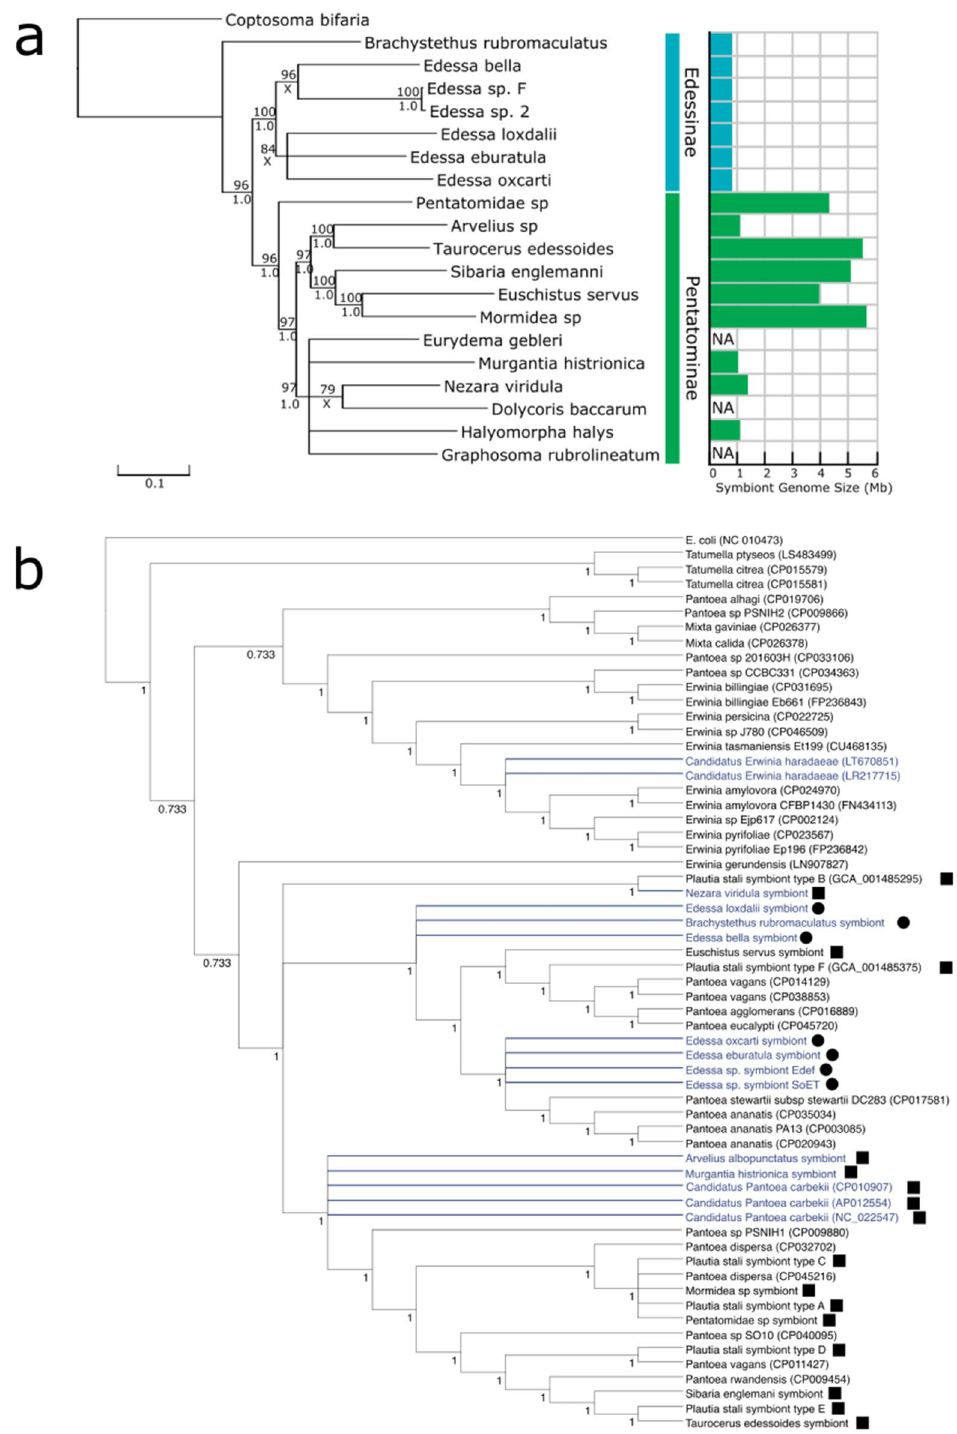
Figure 2. Host and symbiont relationships: ( a ) Stink bug mitochondrial tree with their respective symbiotic bacterial genome size. Nodes with lower than 60% bootstrap support were collapsed. Numbers above nodes represent bootstrap support while numbers underneath represent posterior probability from Bayesian Inference run. X indicates lower than 0.8 posterior probability. NA-genome size was not available. ( b ) Consensus cladogram of representative genomes of Erwiniaceae and stink bug symbionts. Individual FastTree reconstructions for the 10 longest protein sequences identified to be common for all taxa using reciprocal best hit Blast. E. coli was used as an outgroup. NCBI accession numbers for genomes are shown in parenthesis. Squares indicate a symbiont of a member of the Pentatominae while circles indicate symbionts of Edessinae. Numbers at nodes indicate Shimodaira-Hasegawa (SH)-like local support values. Taxa that were individually reconstructed are shown as polytomies in